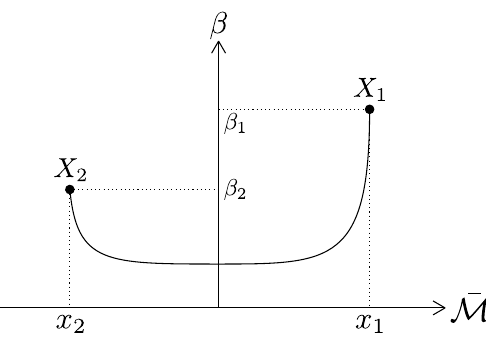
Figure 2 . The geodesic line for the geometry (4.3) with two ends at X 1 = ( x 1 ; (cid:12) 1 ) and X 2 = ( x 2 ; (cid:12) 2